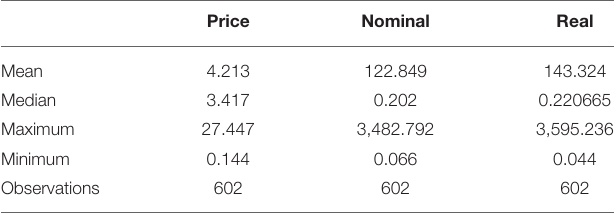
TABLE 1 | Statistical description of the main